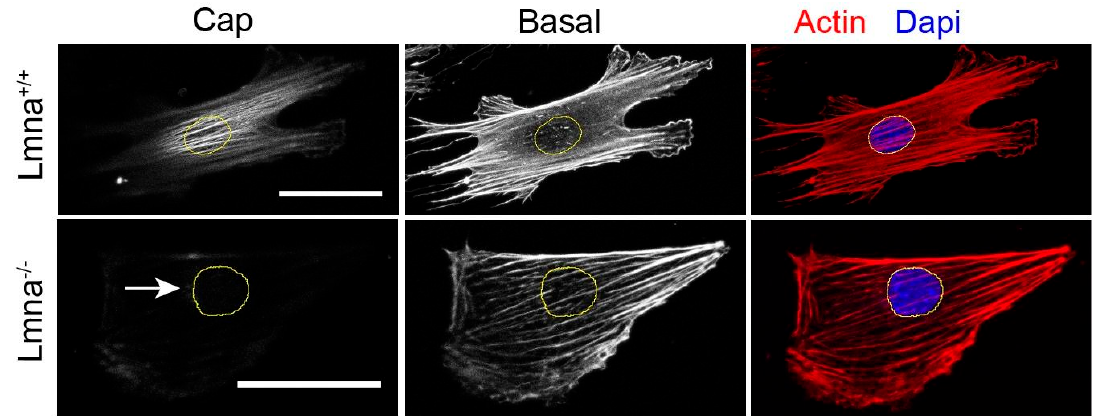
Figure 3. Impaired directional actin cap formation in lmna − / − cells. Cells were seeded on oval microposts causing directed orientation. After staining for F-actin, confocal z-series were recorded, which show oriented actin fibers at bottom of the cell (basal) in both types of cells, along with an oriented actin cap in lmna +/+ cell. This cap on top of the cell is absent in the lmna − / − cell (arrow). Bars represent 10 µ m. Adapted from Tamiello et al.